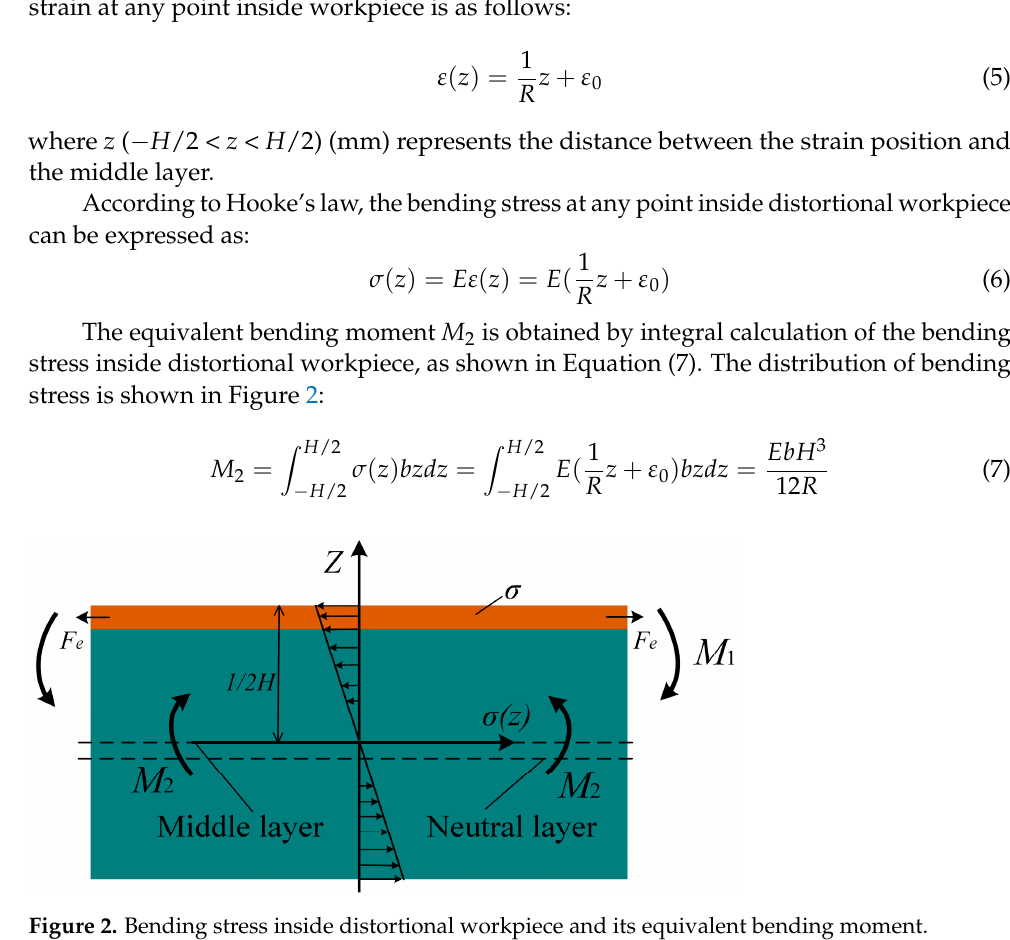
Assuming that the curvature radius of distortional workpiece middle layer is R , the strain at any point inside workpiece is as follows: